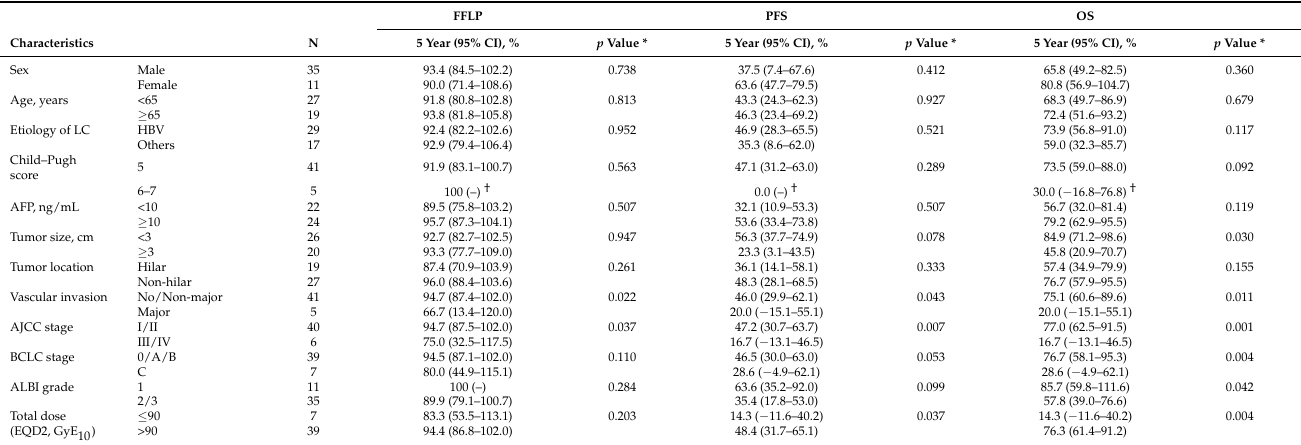
Table 2. Univariate analysis of pretreatment characteristics associated with freedom from local progression (FFLP), progression-free survival (PFS), and overall survival (OS).